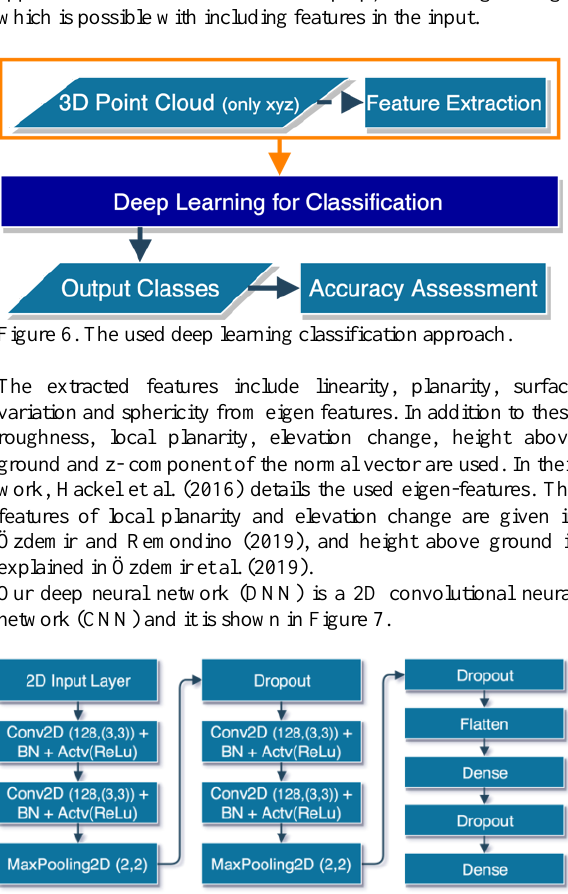
Figure 7. The employed 2D-CNN architecture for the point cloud classification task.